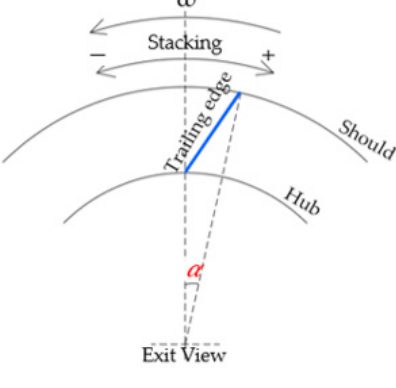
Figure 7. Stacking condition.